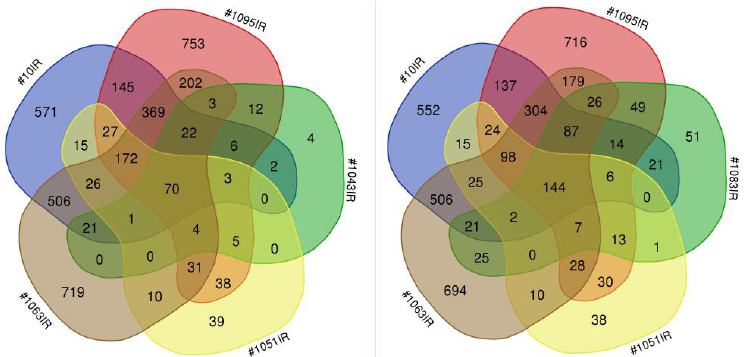
Figure 6. Gene ontology analysis of transcriptomic changes induced by hypofractionated radiation. Venn diagram showing the overlap in GO terms of differentially expressed genes (DEGs) identified through comparison of isogenic GSC and GSC_IRs.